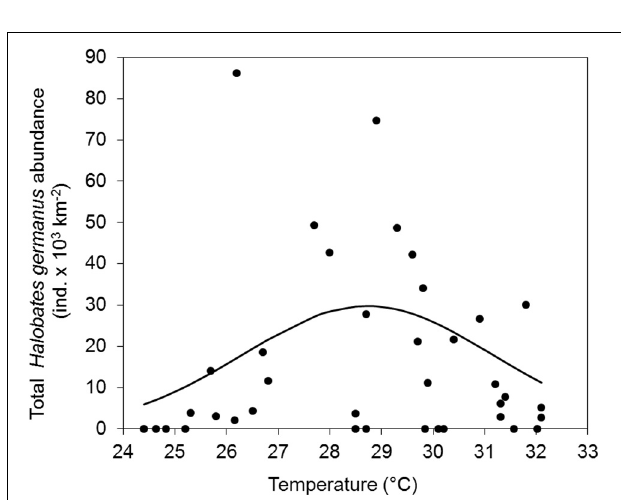
FIGURE 7 | Temperature preference of Halobates germanus at the fixed station in the central Red Sea during 2016–2018. Gaussian curve is adjusted to total H. germanus abundances versus temperature ( ◦ C). The optimum temperature estimated is as 28.2 ◦ C.